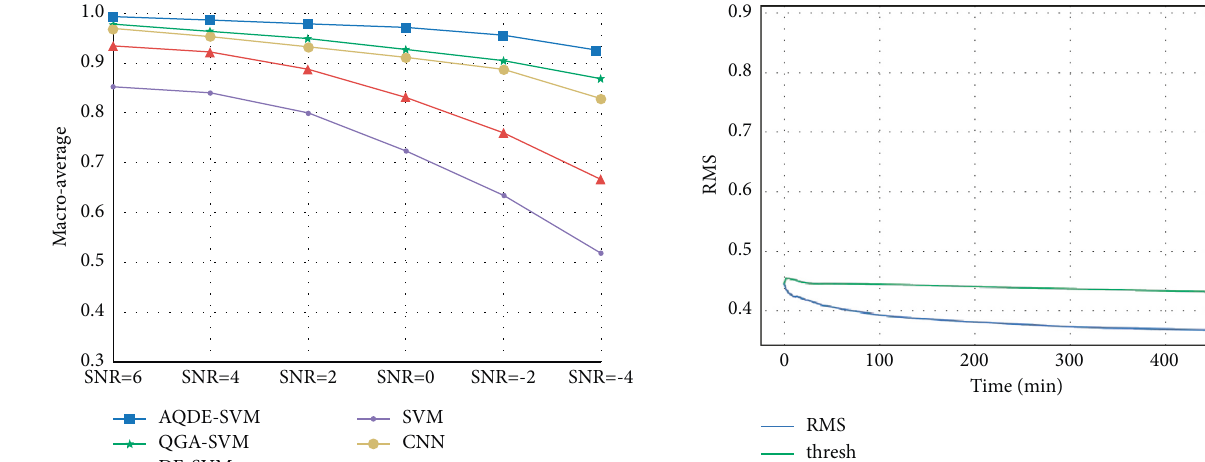
Figure 6: Macroaverage of each algorithm under noise interference.